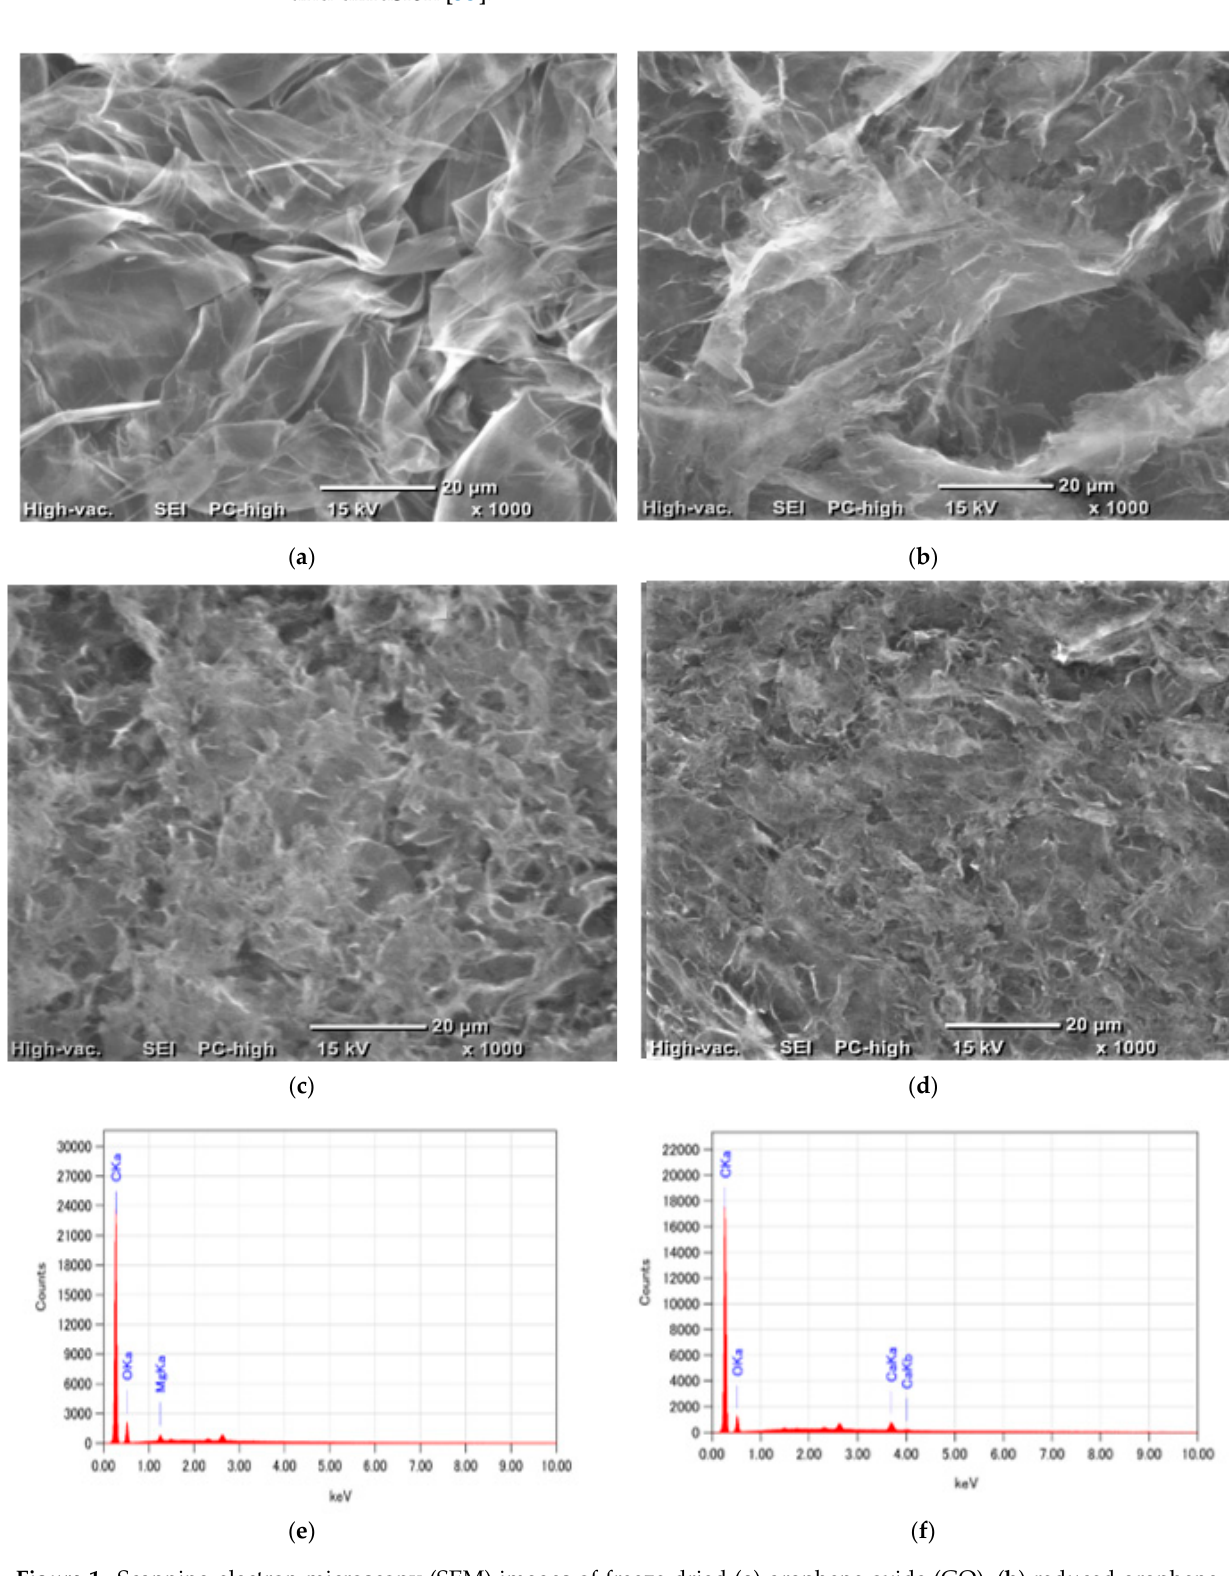
Figure 1. Scanning electron microscopy (SEM) images of freeze dried ( a ) graphene oxide (GO), ( b ) reduced graphene hydrogels (rGH), ( c ) rGH-Mg, ( d ) rGH-Ca. EDX spectrum with elemental distribution for ( e ) rGH-Mg and ( f ) rGH-Ca.